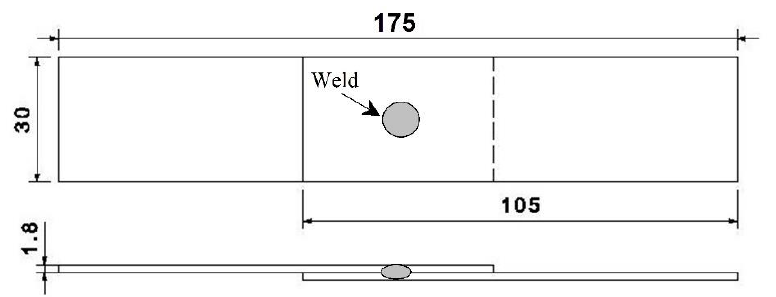
Figure 2. Dimensions of the static tensile shear test sample (dimensions in mm).